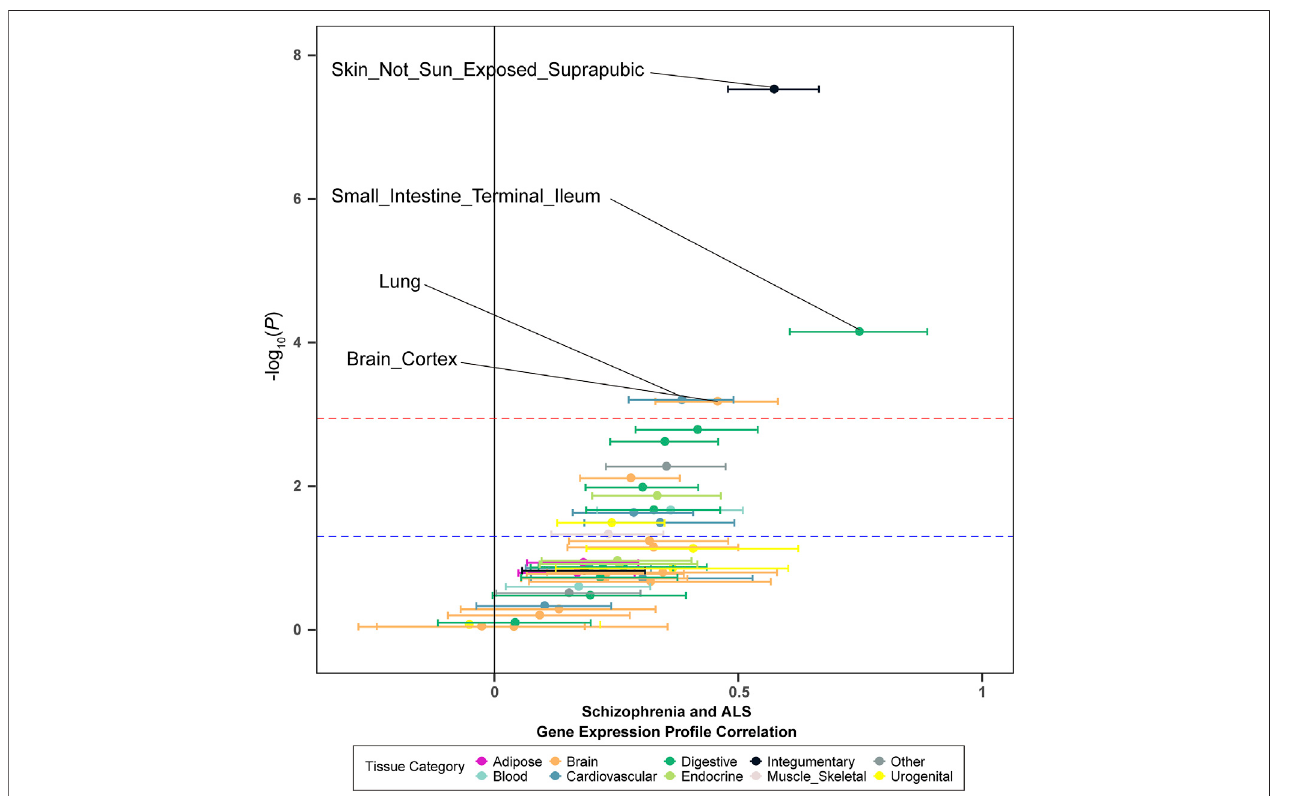
FIGURE 2 | Tissue-speci fi c disease-inferred gene expression pro fi le correlation between schizophrenia and ALS. The red dashed line demarks the multiple-test corrected threshold ( p (cid:1) 0.05/48), while the blue dotted line demarks the nominal threshold ( p (cid:1) 0.05).